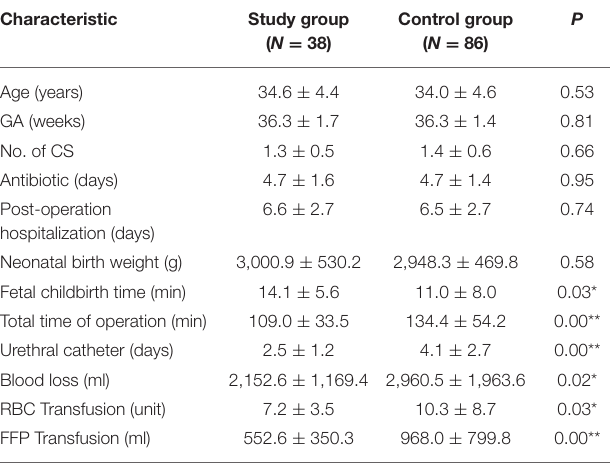
TABLE 1 | Comparisons of surgical information between study and control groups.